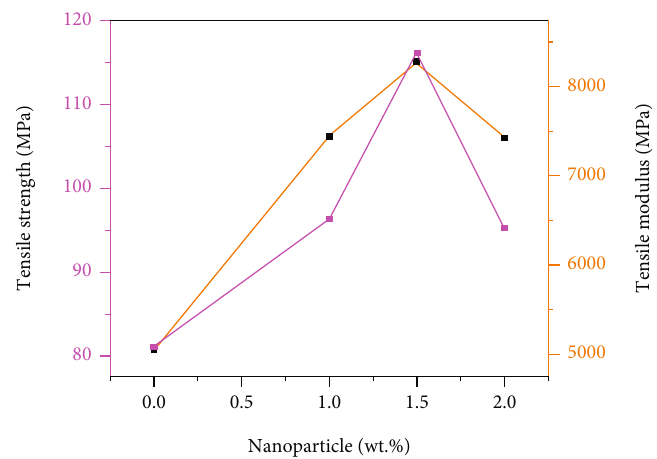
Figure 4: Mechanical properties of the epoxy